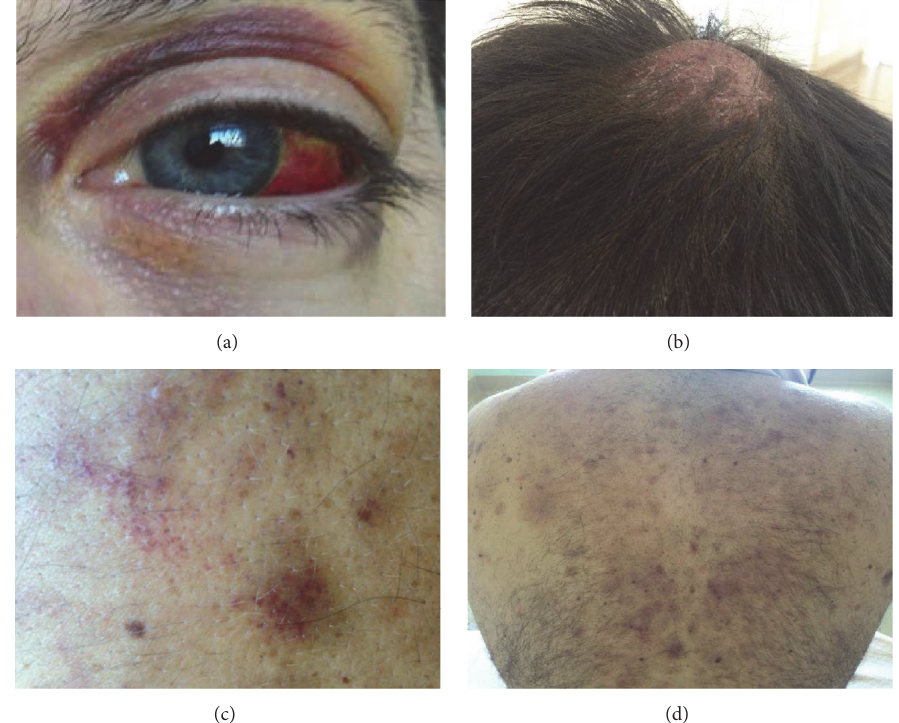
Figure 1: Clinical presentation: close view picture of conjunctival bleeding with eyelid hemorrhage and periorbital edema (a); voluminous infiltrative and erythematous nodule localized on the scalp (b); detailed view of bruise-like brown cutaneous nodules and plaques (c); multiple bruise-like brown cutaneous nodules and plaques localized on the back (d).